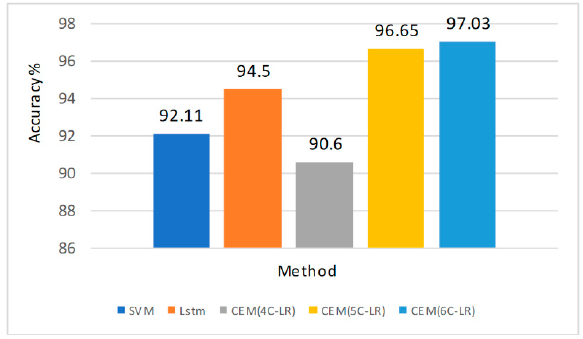
Figure 6. Results experimented on corpus of UIT-VSFC.